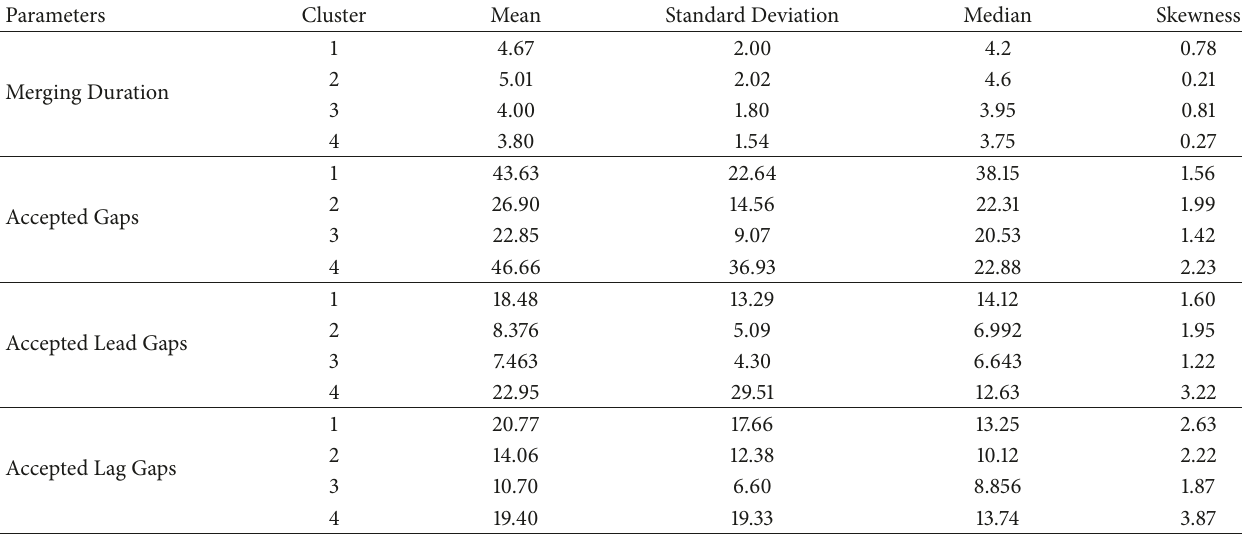
Table 4: Basic statistics of merging duration and gap acceptance for different